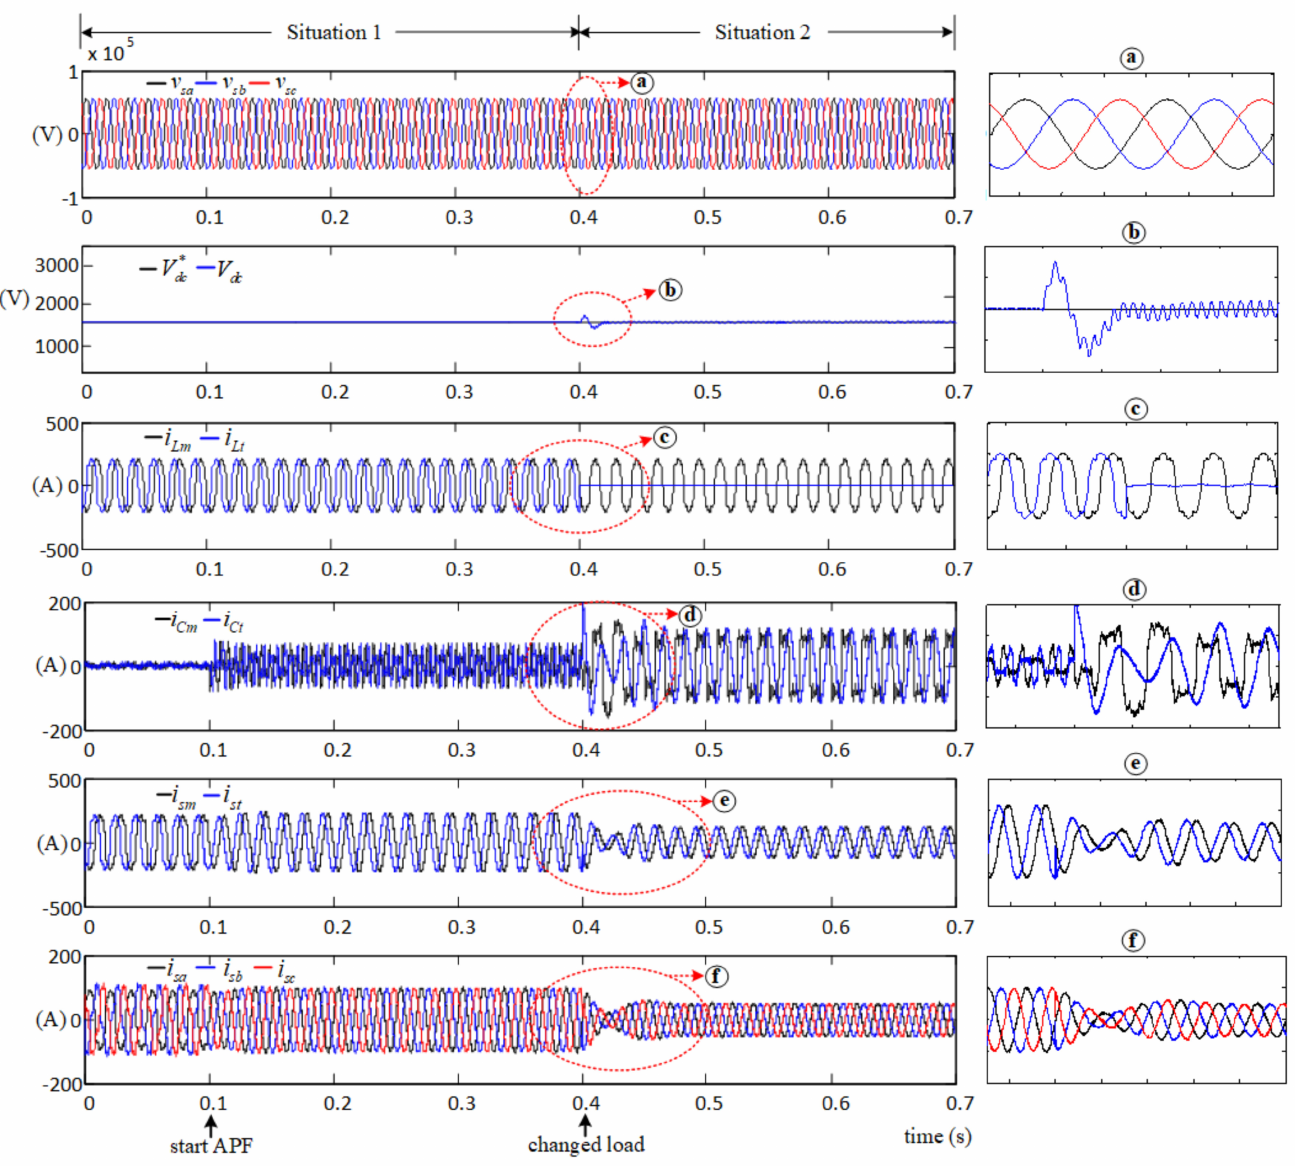
Figure 9. The testing results of the harmonic mitigation performance in the electric railway system using the